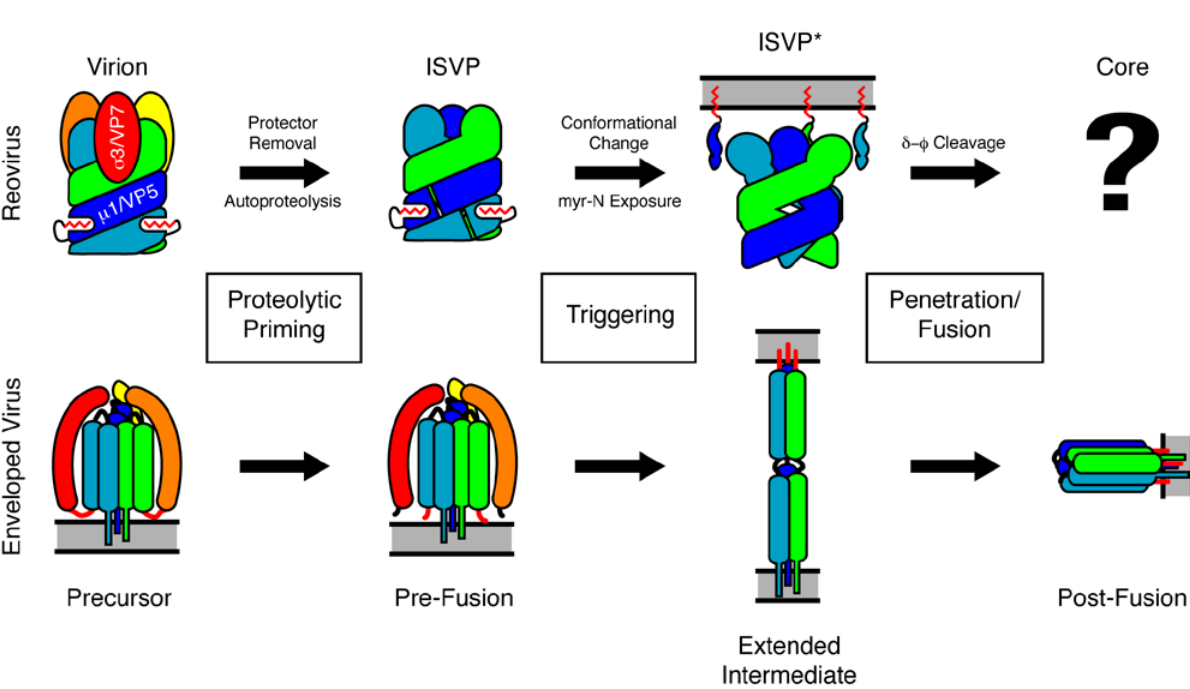
in warm colors and HA 1 2